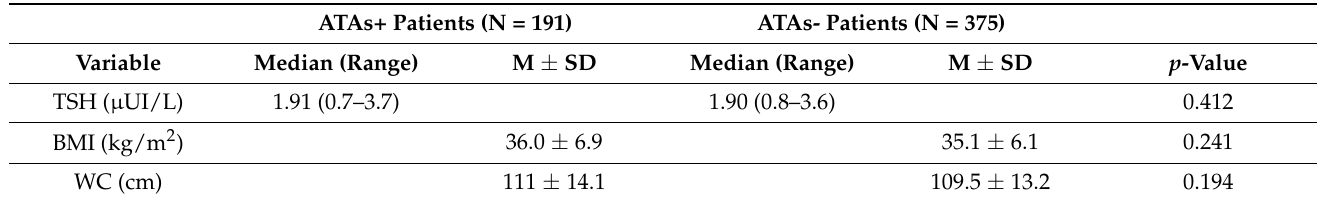
Table 3. TSH serum levels, BMI, and WC values according to ATAs’ status in female patients.